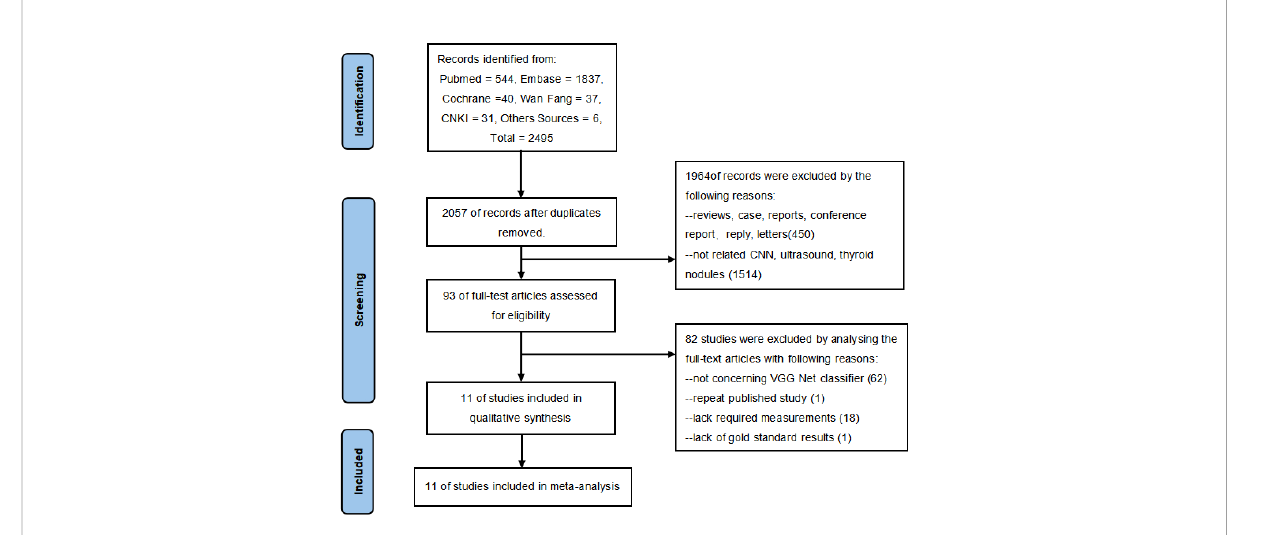
FIGURE 1 Study fl owchart. Eleven studies were included in this meta-analysis.